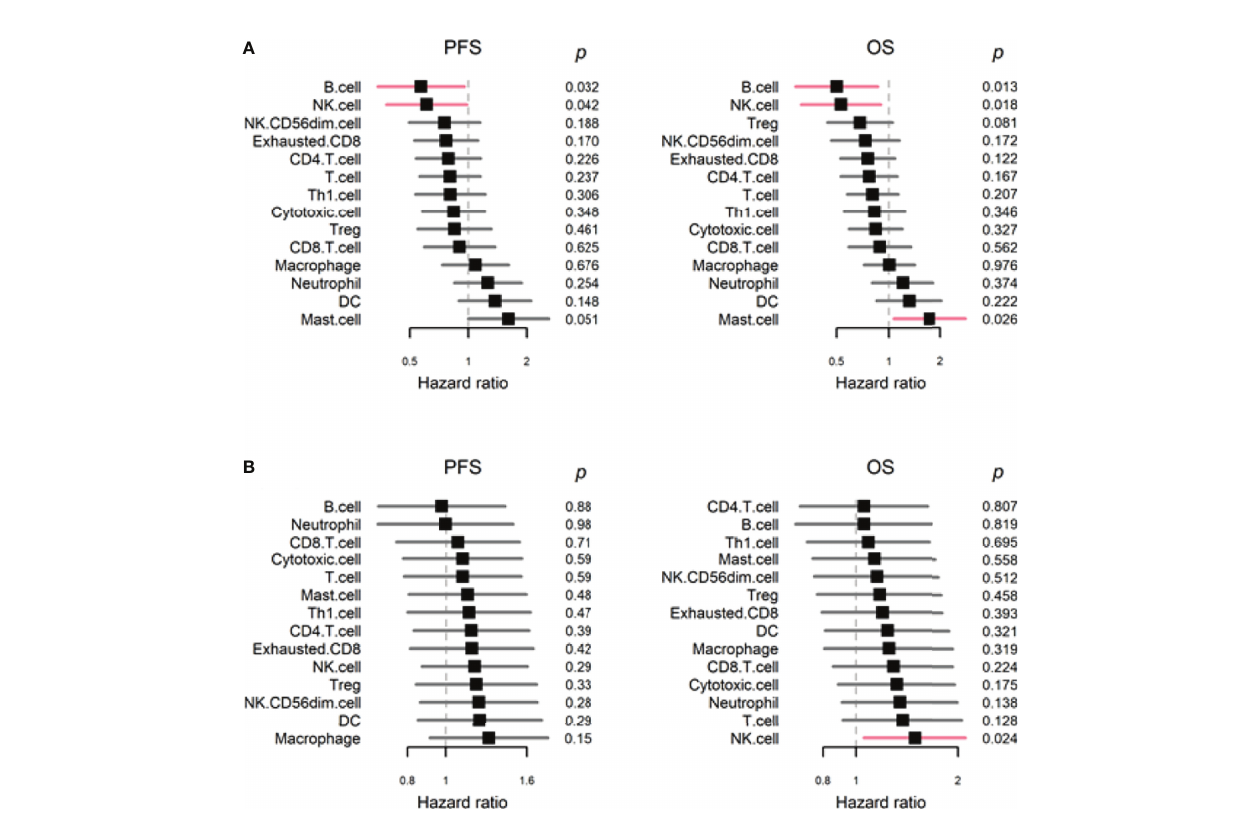
FIGURE 4 | Progression-free survival (PFS) and overall survival (OS) analyses of proportional values for different immune cell signatures in (A) our cohort and (B) The Cancer Genome Atlas cohort. (DC, dendritic cells; NK cells, natural killer